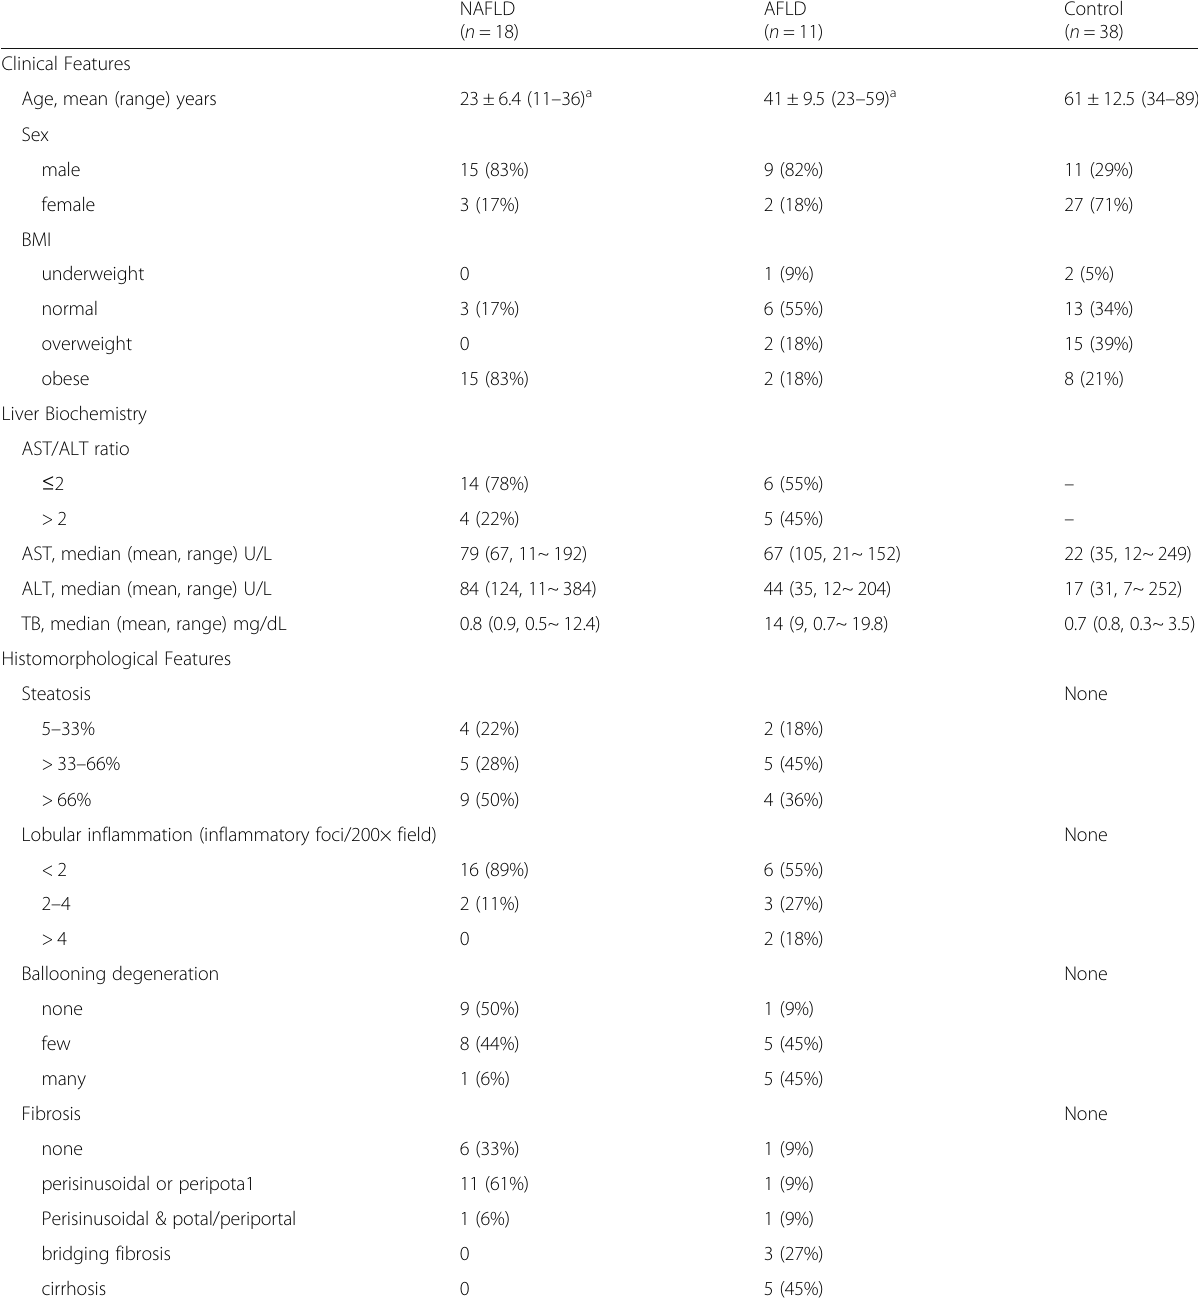
Table 1 Clinicopathologic and histomorphologic features in hepatic steatosis